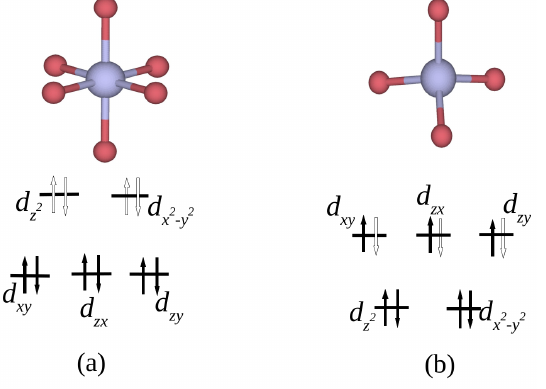
Figure 6. Cobalt geometries and the corresponding crystal-field splitting diagrams. Black filled arrows represent occupied electron states, while the hollow arrows characterize empty electron states. Bluish grey and red spheres represent Co and O atoms, respectively. ( a ) Co 3 + ion in the octahedral geometry (representative for Co1, Co2 and Co3) with electron configuration t 6 4 empty 3 d states. ( b ) Co 2 + ion in the tetrahedral geometry (Co4) with electron configuration e 4 g t 3 i.e., containing spin-up unpaired d